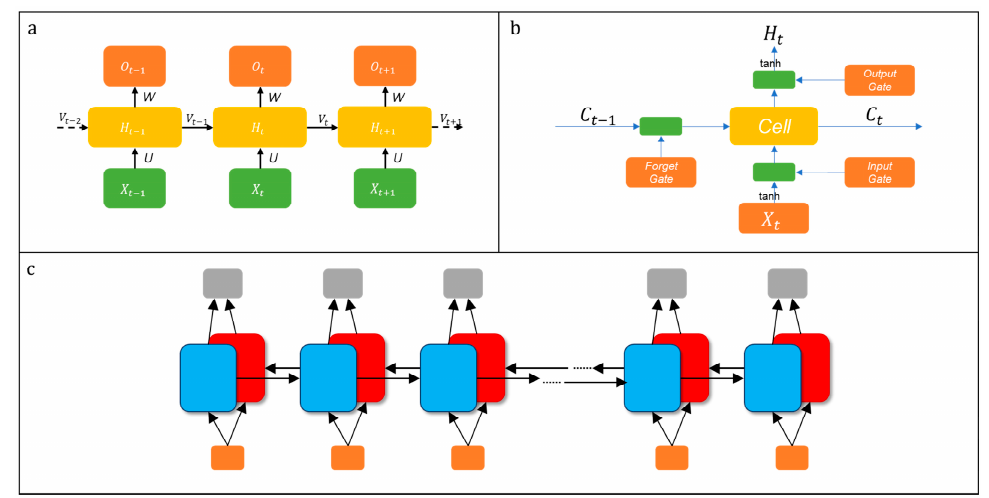
Figure 3. The structure of RNN and LSTM. ( a ) Simple-RNN; ( b ) LSTM unit; and ( c ) Bidirectional LSTM.